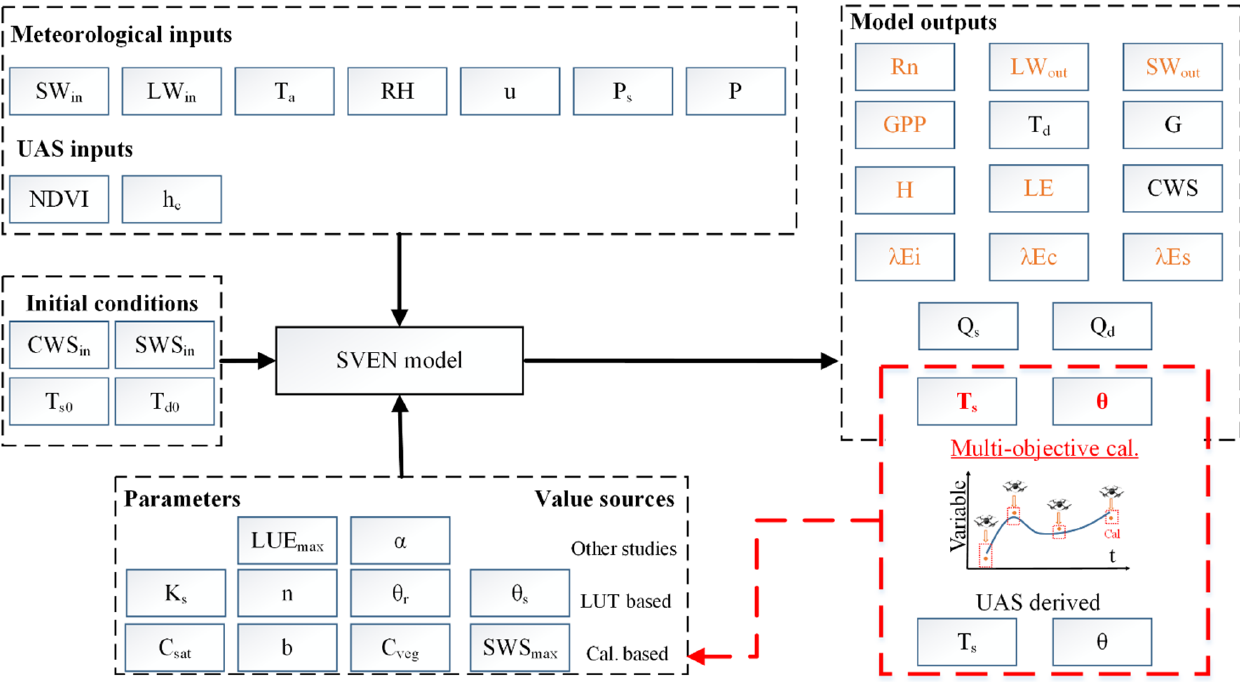
Figure 4. Model implementation in this study. UAS and meteorological data were used as inputs for the SVEN model. Values of the SVEN parameters were obtained from other studies, look-up tables (LUT based), or model calibration with UAS-derived variables (Cal. based). In the model outputs, variables written in red ( T s and θ ) refer to the variables calibrated with UAS-derived observations or estimates. The red shaded box represents the multi-objective calibration process with UAS-derived T s and θ . The variables written in orange are retrievable using remote sensing